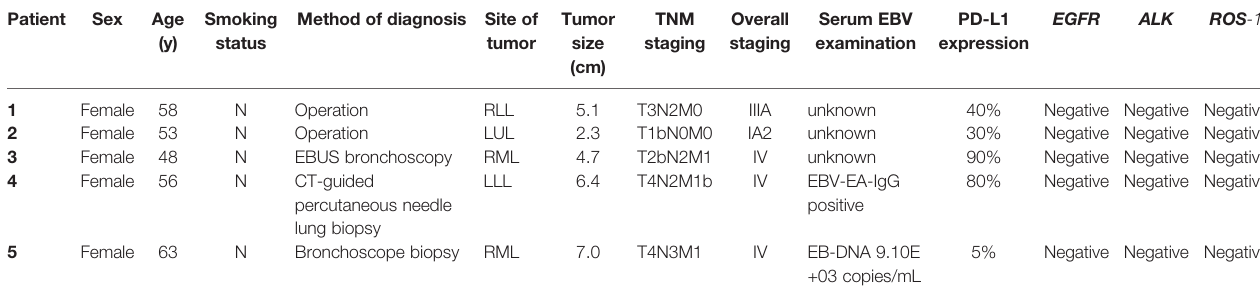
TABLE 1 | Demographic characteristics of the patients with PPLELC.